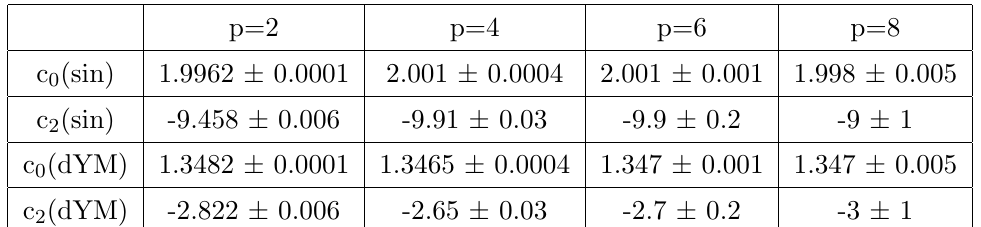
0.0005) sine (cid:24)